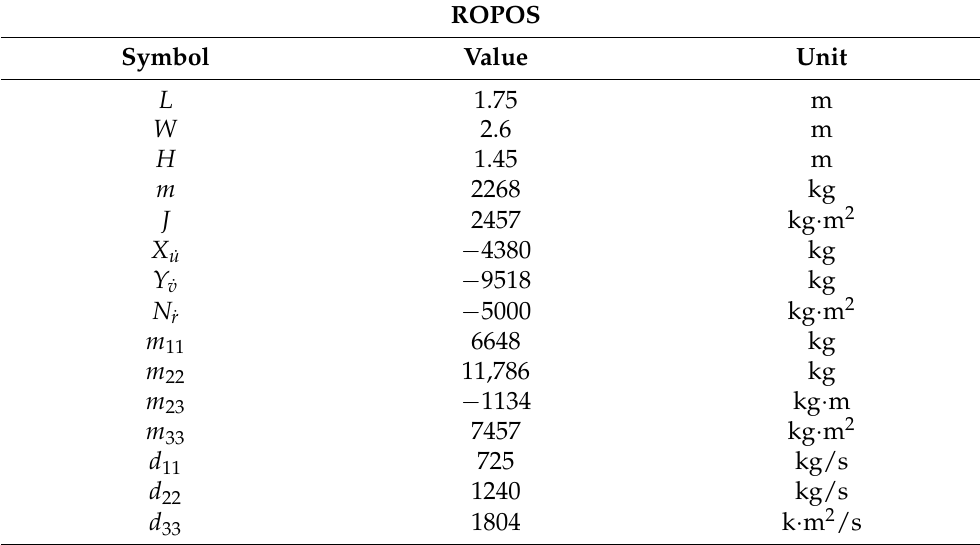
Table 1. Parameters of ROPOS